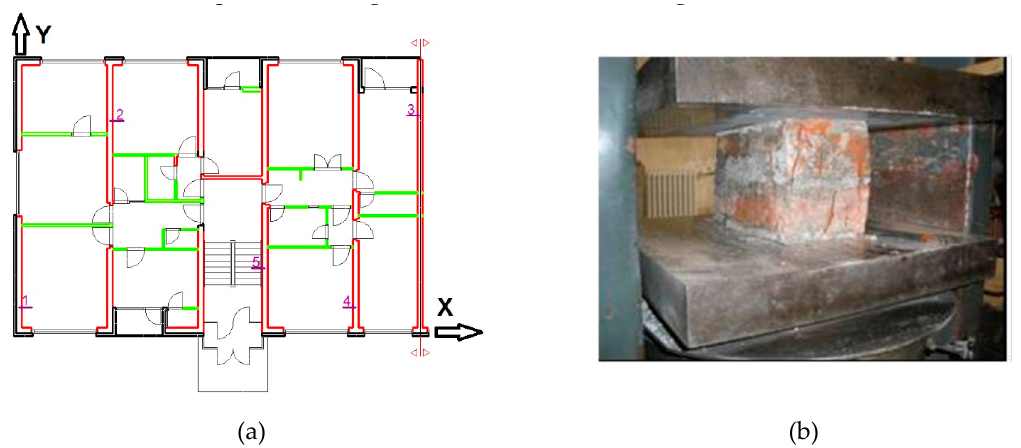
Figure 4. ( a ) Location of the samples for determination of the compressive strength of bricks; ( b ) tested sample.